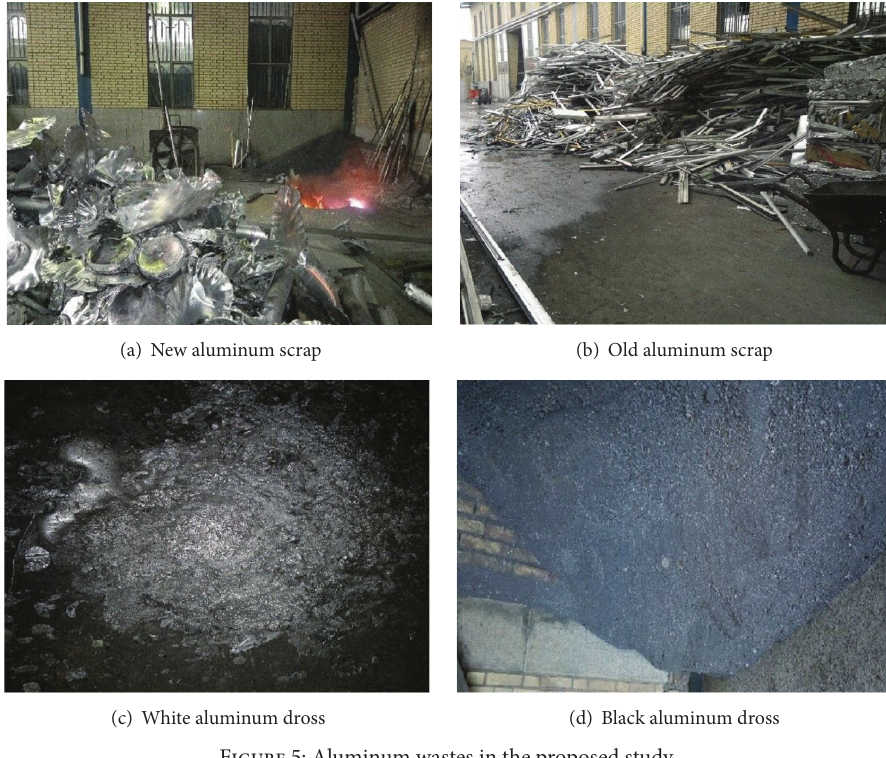
Figure 5: Aluminum wastes in the proposed study.